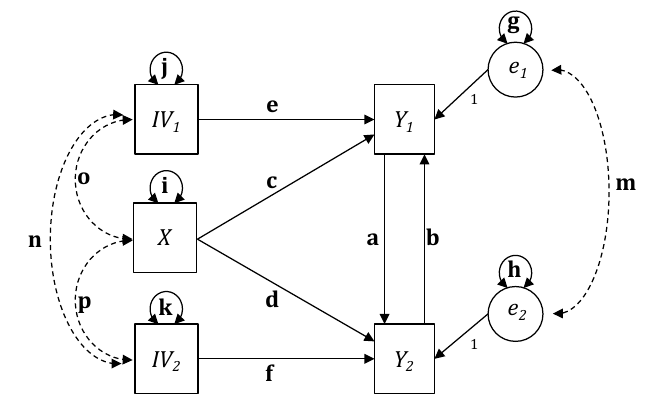
Figure 3 Identifying Simultaneous Feedback